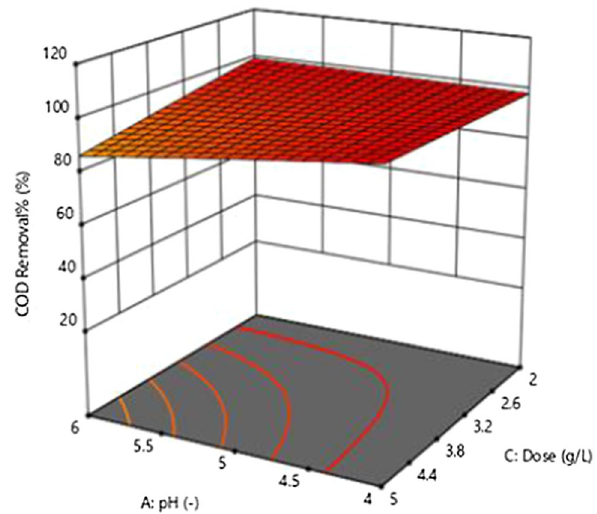
Fig. 7 3D surface plot of the effect of variation of electrolyte dos- age and pH with % removal of COD (conditions: electrolysis time = 30 min and current density = 20 mA/cm 2